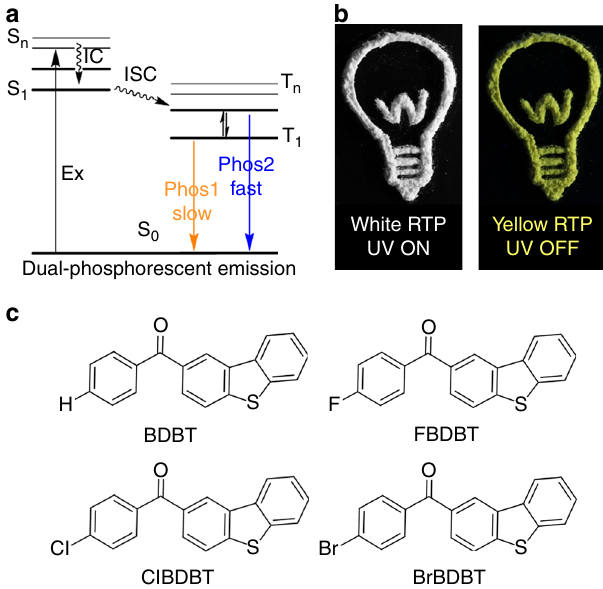
Fig. 1 Strategy and example to develop single molecule white light-emitting RTP system. a Jablonski diagram for dual phosphorescent emission. b Photo-pattern of ClBDBT. A lamp was drawn using powder of ClBDBT. The white lamp was taken when excitation source is on, the yellow lamp was taken when excitation source is off. c Molecular structures